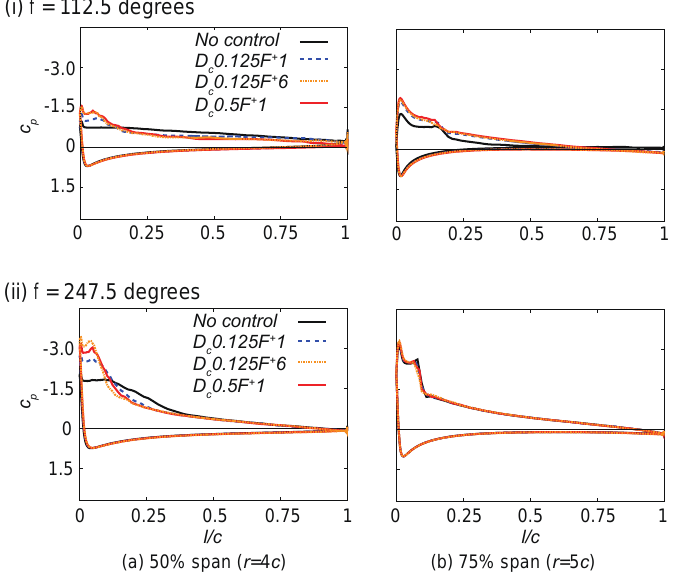
Figure 9. Distributions of the phase-averaged pressure coefficient ( c p ) over the blade surface at ( a ) 50% and ( b ) 75% of the span from the blade root.